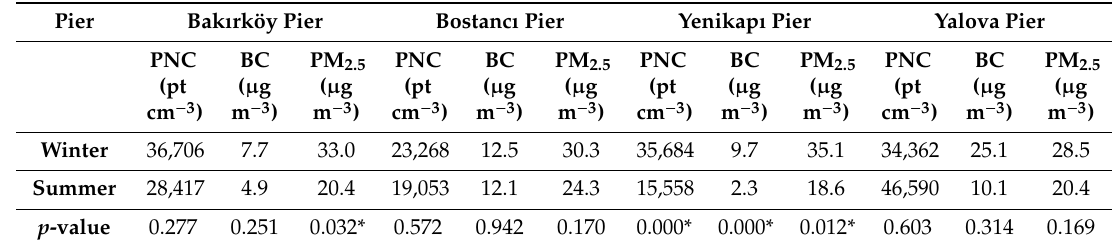
Table 4. At pier t -test results for the di ff erences between season (mean di ff erence = summer – winter).